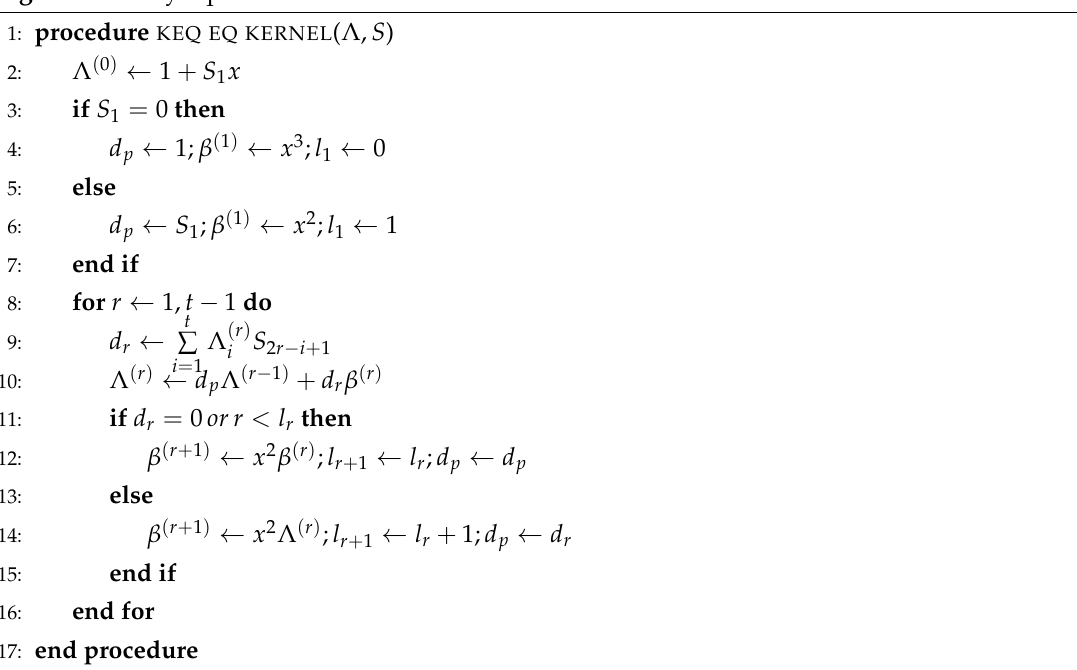
Algorithm 2 Key-equation kernel.